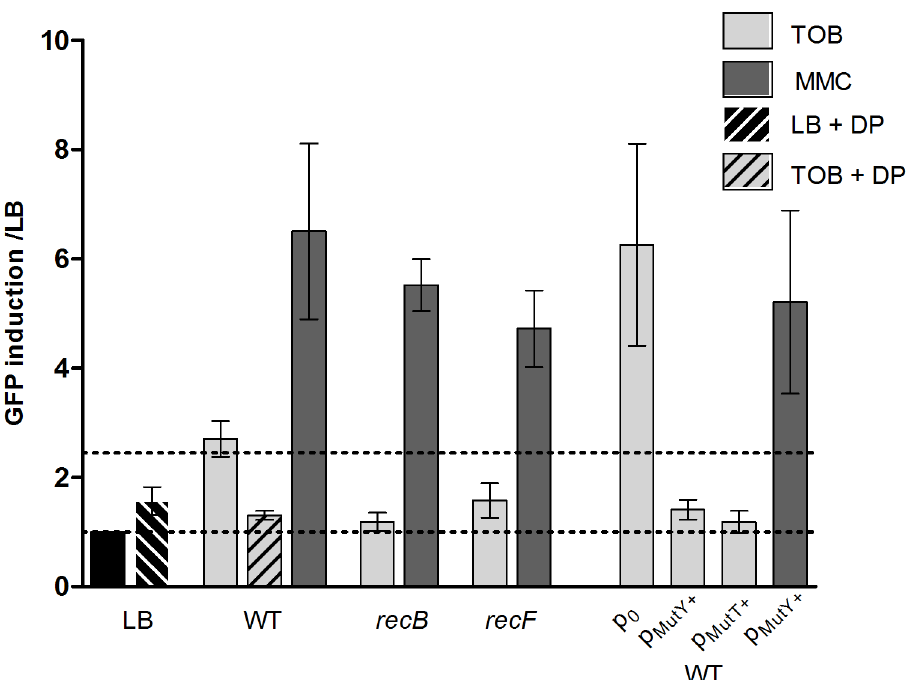
Figure 2. Factors modulating SOS induction by tobramycin in V.cholerae . Histogram bars show the ratio of GFP fluorescence in a given strain in the presence of antibiotic over fluorescence of the same strain grown in LB and thus reflect the induction of SOS by the antibiotic. p0 stands for empty pTOPO plasmid. pMutY + stands for pTOPO-MutY + (p9476). TOB: tobramycin 0.01 m g/ml. MMC: mitomycin C 0.1 m g/ml. DP: 2,2 Dipyridyl 0.5 mM.